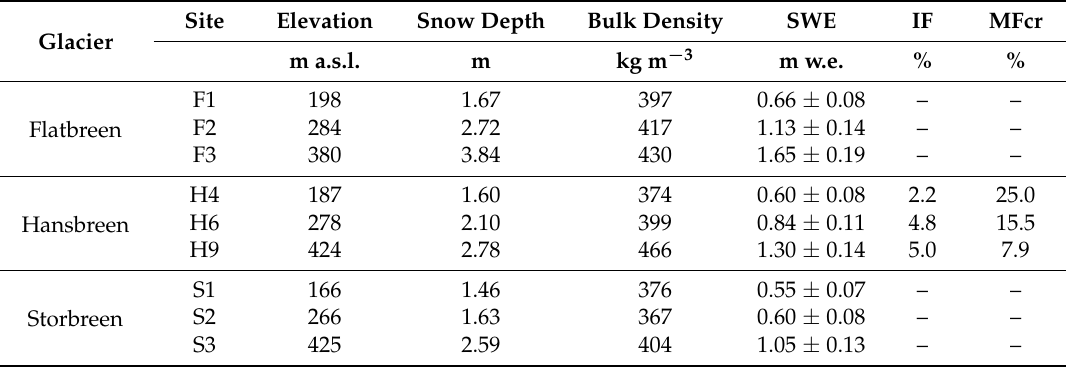
Table 3. Basic features of the snow cover at the individual study sites: (SWE) snow water equivalent; percentage of total snow depth: (IF) Ice Formations; (MFcr) Melt-Freeze